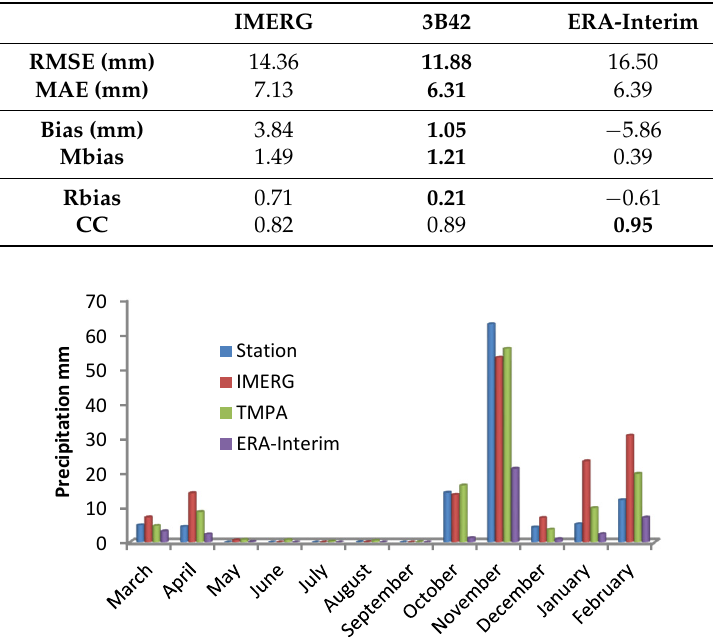
Table 9. Statistical indices of monthly precipitation in Bushehr area (mid-March 2014 to February 2015).